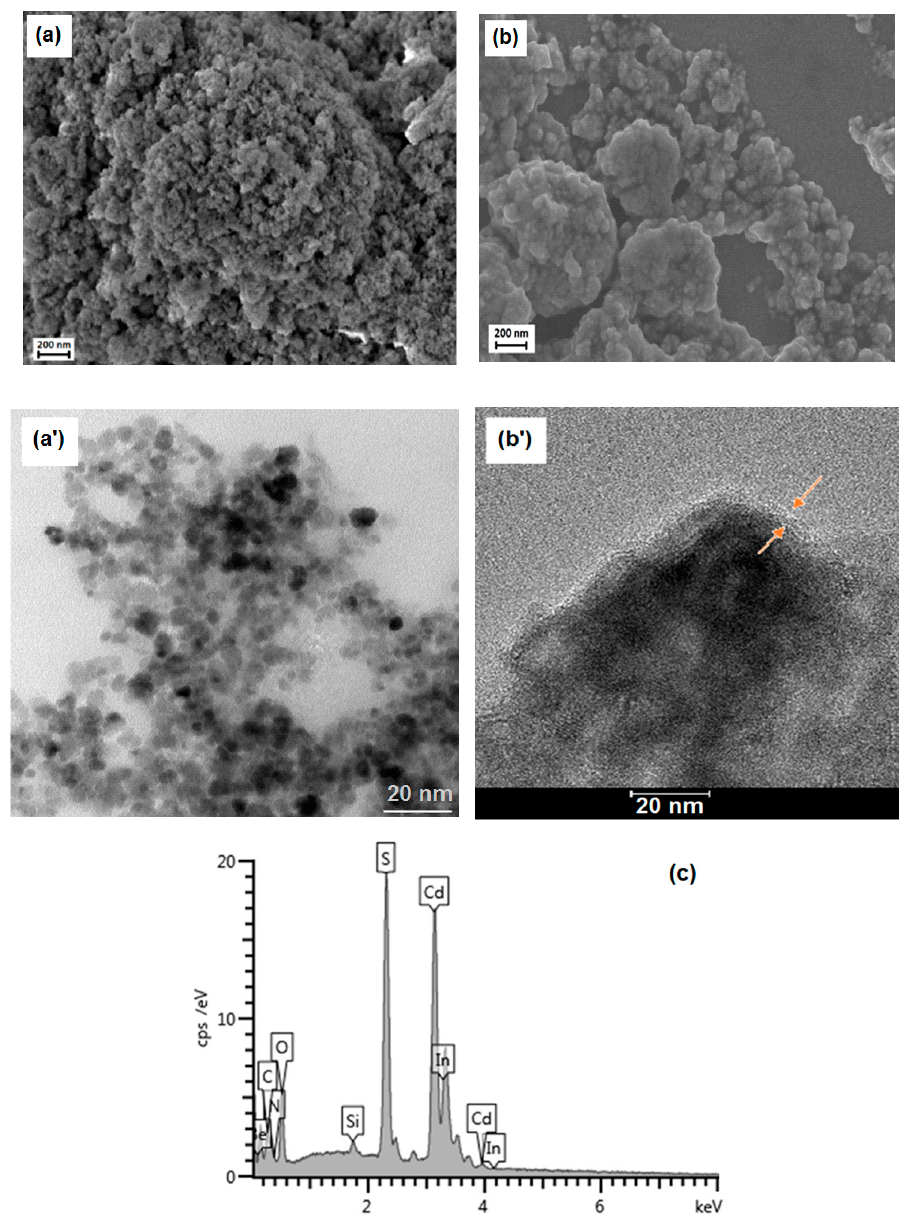
Figure 5. Scanning Electron Microscopy (SEM), (Merlin, Zeiss, Stuttgart, Germany) and Transmission Electron Microscopy (TEM), (Libra 120 Plus, Zeiss, Stuttgart, Germany) images of ( a,a’ ) hydrophilic CdS nanoparticles (scale bar is 200 nm for SEM and 50 nm for TEM); ( b,b’ ) hydrophobic CdS nanoparticles deposited onto indium tin oxide (ITO) at 25 mN/m constant surface pressure (L-B transfer, 50 layers, SEM) and TEM of hydrophobic CdS used in the L-B transfer (scale bars: 200 nm SEM and 20 nm TEM); and ( c ) Energy Dispersive X-Ray Spectroscopy (EDS) spectrum of drop-cast CdS nanoparticles on ITO substrate.